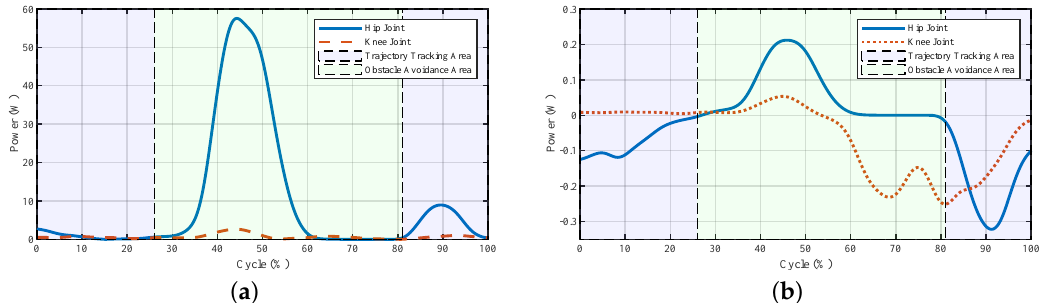
Figure 9. Joint powers of the system to avoid tripping during stepping over the door threshold. ( a ) Powers of the exoskeleton and ( b ) powers of the interaction. The exoskeleton’s more considerable power reflected that the virtual forces took effects, and the pilot’s corresponding powers showed that there were confronted forces between the robot and the pilot.